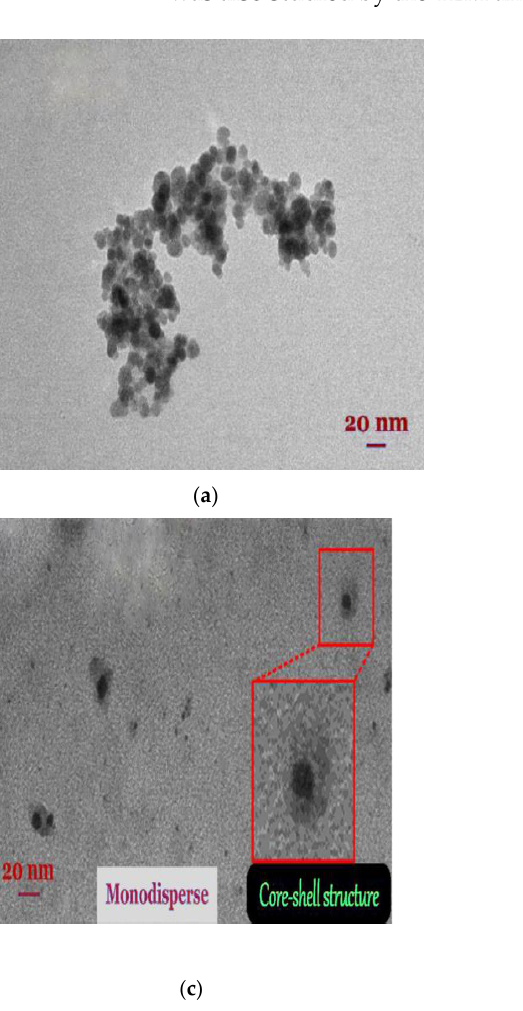
Figure 3. Magnetization curves (inset: magnetic separation of Fe 3 O 4 /CS/PEI nanocomposite) of the synthesized Fe 3 O 4 NPs, Fe 3 O 4 /CS, and Fe 3 O 4 /CS/PEI nanomaterials. According to Figure 3, all synthesized nanomaterials are ferromagnetic with satura- tion magnetization (M s ) of 71, 62, and 51 emu g −1 for Fe 3 O 4 , Fe 3 O 4 /CS, and Fe 3 O 4 /CS/PEI, respectively. The clear drop of saturation magnetization by the modification of magnetite with chitosan was attributed to the non-magnetic properties of chitosan. Similarly, the drop occurred when the PEI was added. This was attributed to the diamagnetic proper- ties of the polymer. The drop of magnetic properties after the modification of magnetite NPs was reported in previous studies [55,56]. This order of magnetism of the three syn- thesized nanomaterials was reflected on their time of separation with an external magnet that was found to equal 69 s, 93 s, and 119 s for Fe 3 O 4 , Fe 3 O 4 /CS, and Fe 3 O 4 /CS/PEI, re- spectively. Figure 3 (inset) showed the magnetic separation of Fe 3 O 4 /CS/PEI